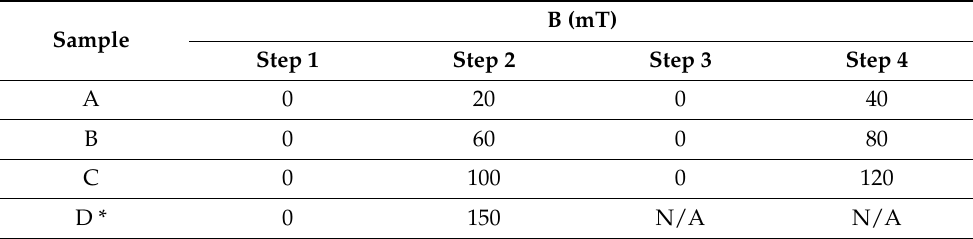
Table 1. Magnetic induction (B) profile during solidification.